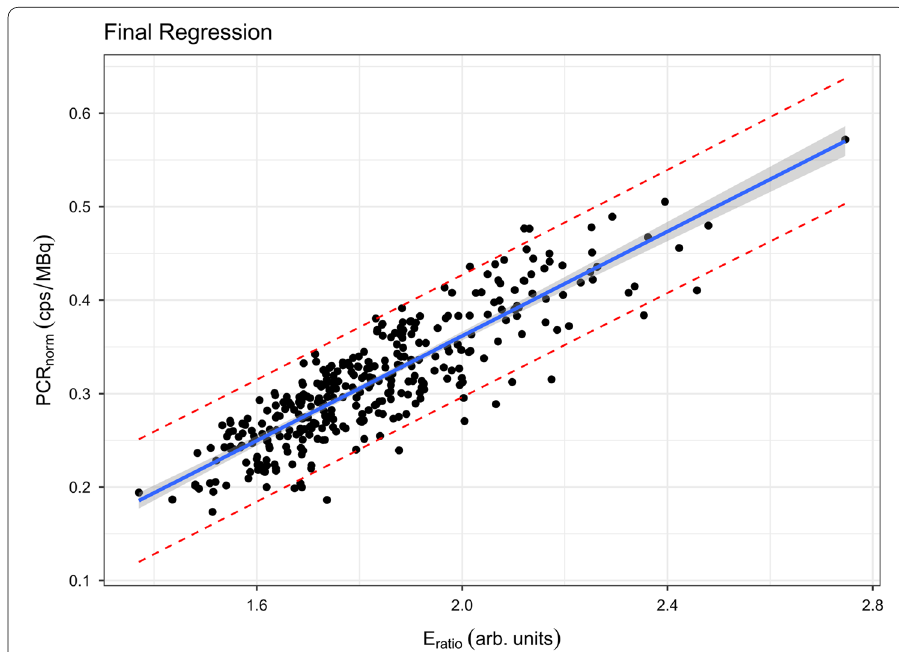
Fig. 1 Final linear regression of perfusion count rate normalised to 1 MBq of administered [ 99m Tc]Tc-MAA, and a camera-collimator sensitivity of 1 cps/MBq (PCR norm ) as a function of the dual energy window count ratio of the ventilation study ( E ratio ). Regression line (blue solid line), 95% confidence band (dark grey), and 95% prediction bands (red dashed lines). Image generated in